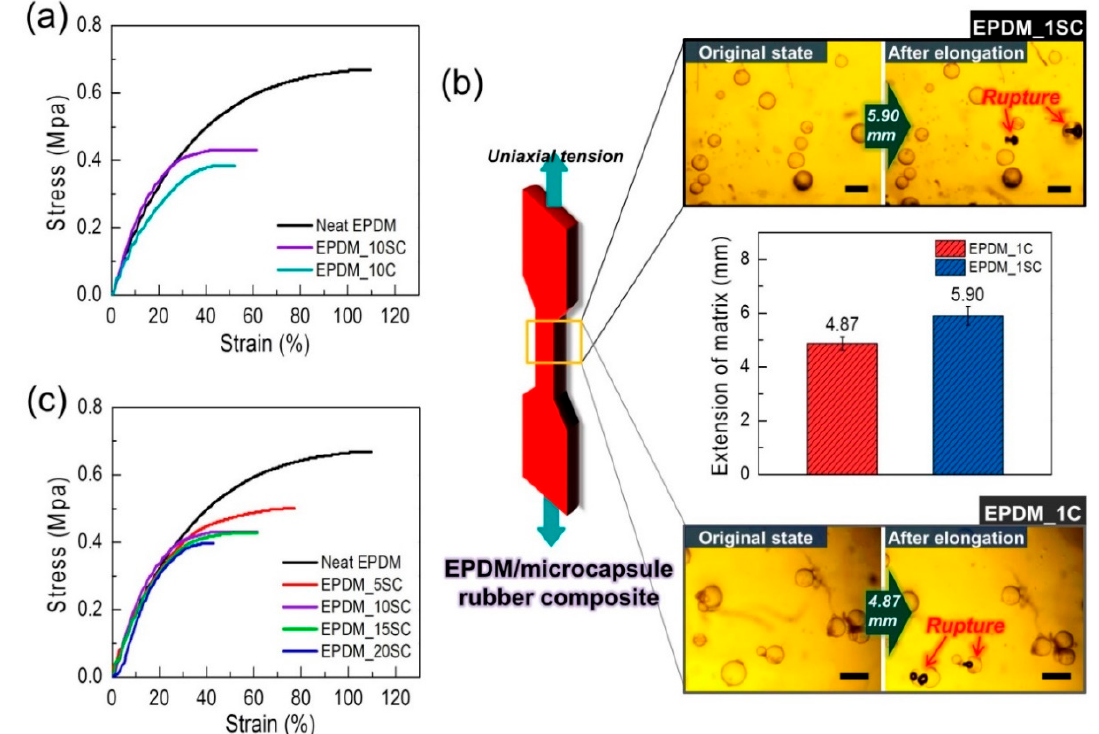
Figure 6. ( a ) The stress–strain curves of neat EPDM rubber, the EPDM/microcapsule